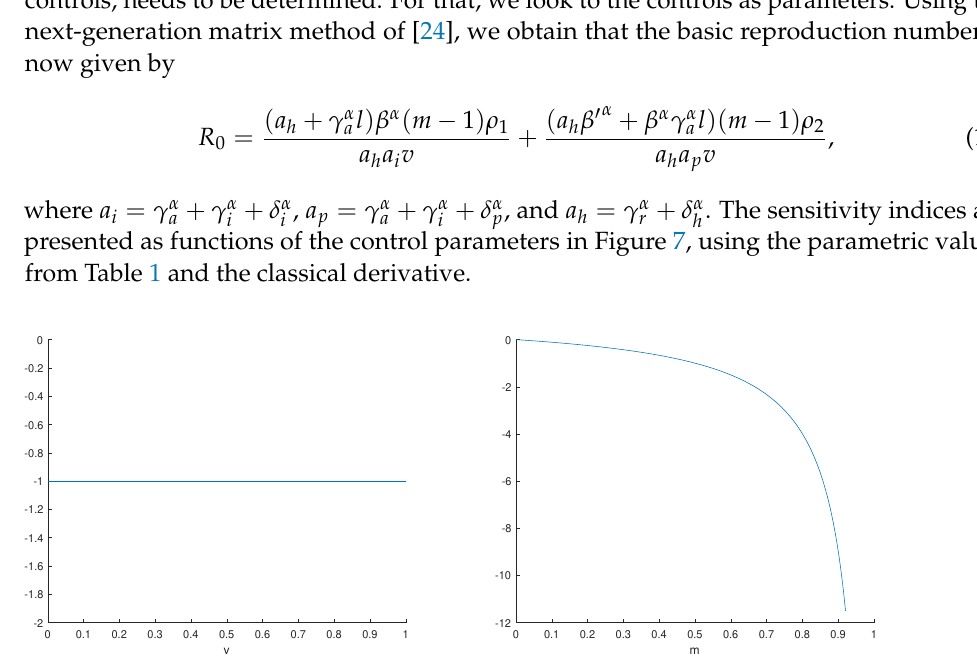
Figure 7. Sensitivity index of the basic reproduction number (12) with respect to the control variables v (left) and m